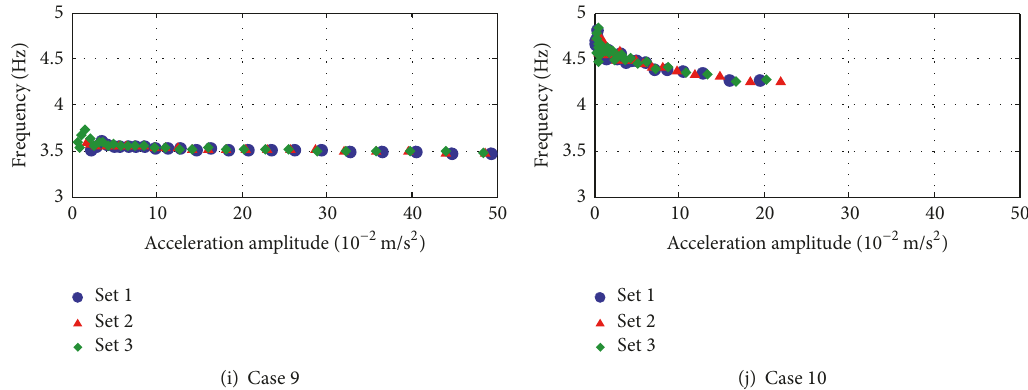
Figure 11: Amplitude-dependent natural frequencies estimated from free vibration